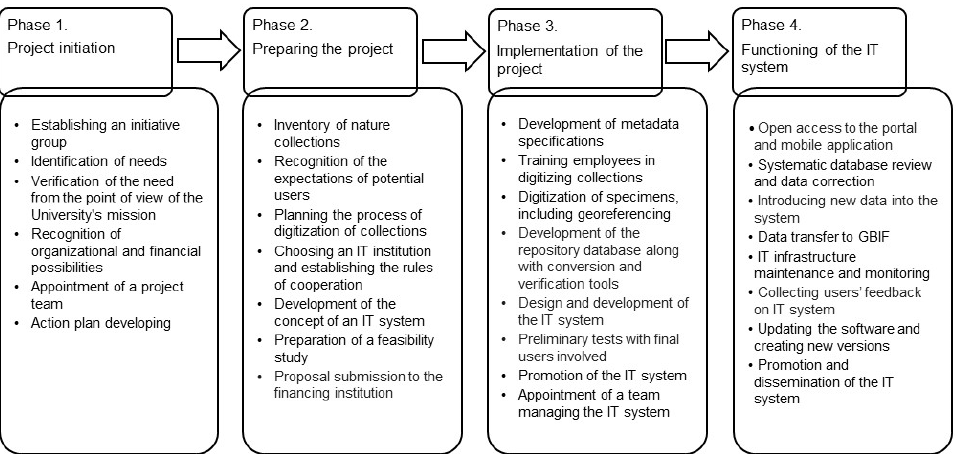
Figure 1. Development of the system for collecting, analysing, and sharing digitized data on biodi- versity based on the Natural History Collections of Adam Mickiewicz University in Poznań (AMUNATCOLL IT).